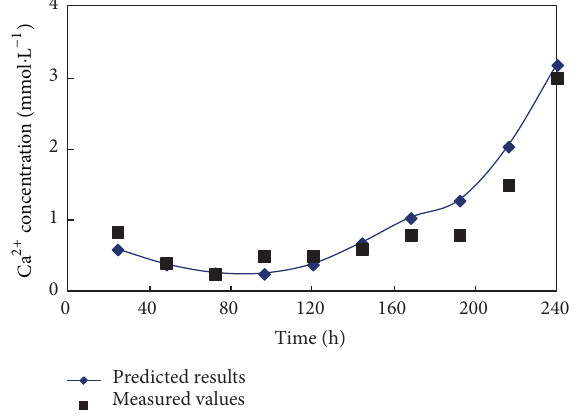
Figure 4: Comparison of the measured values and predicted results for the Ca 2+ concentration of the soil leachate in a penetration